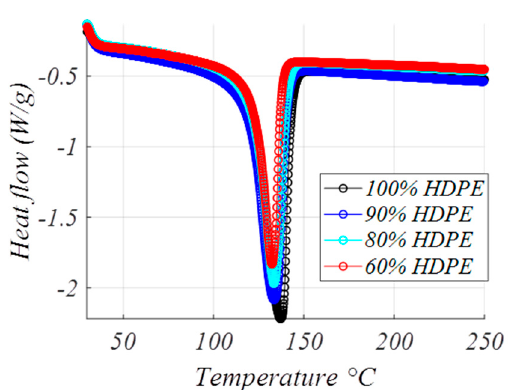
Figure 4. Comparative thermograms (heat flow versus temperature) showing the melting peaks of HDPE, 90% HDPE + 10% ground tire rubber (GTR), 80% HDPE + 20% GTR and 60% HDPE + 40% GTR.